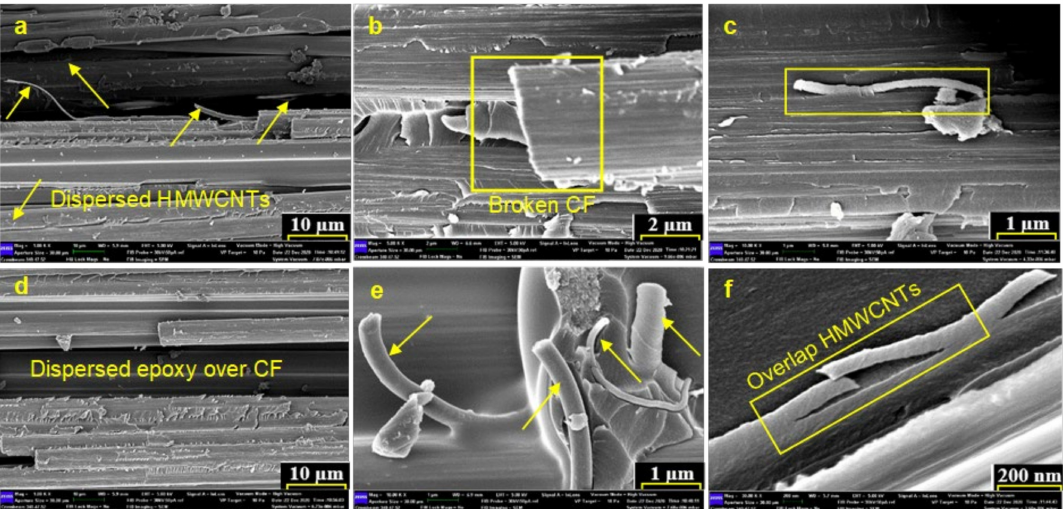
Figure 9. FESEM micrographs of the fractured surfaces ( a – c ) 0.2 wt.% and ( d – f ) 0.4 wt.% HMWCNT reinforced composites with visible HMWCNTs near fractured